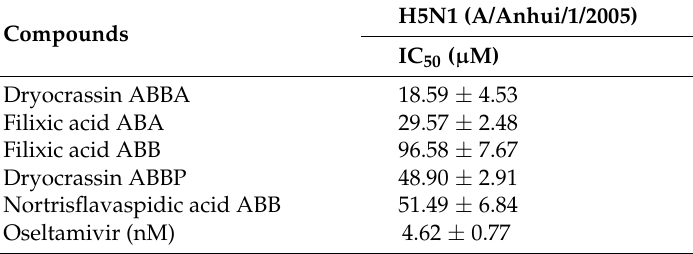
Table 4. Inhibitory effects of the five phloroglucinols on influenza virus (H5N1) NA.